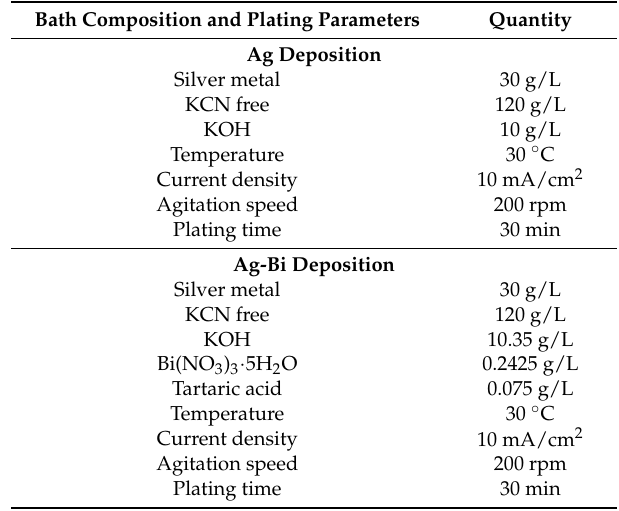
Figure 1. ( a ) The sketch of Ag/Ag-Bi coatings; ( b ) scanning electron microscope (SEM) image of Ag coating on as-deposited surfaces; ( c ) SEM image of Ag coating on the polished surfaces perpendicular to the T direction; ( d ) SEM image of Ag-Bi coating on the as-deposited surfaces; and ( e ) SEM image of Ag-Bi coating on the polished surfaces perpendicular to the T direction. Table 1. Solution composition and operating parameters of electrodeposited Ag and Ag-Bi coatings. Bath Composition and Plating Parameters